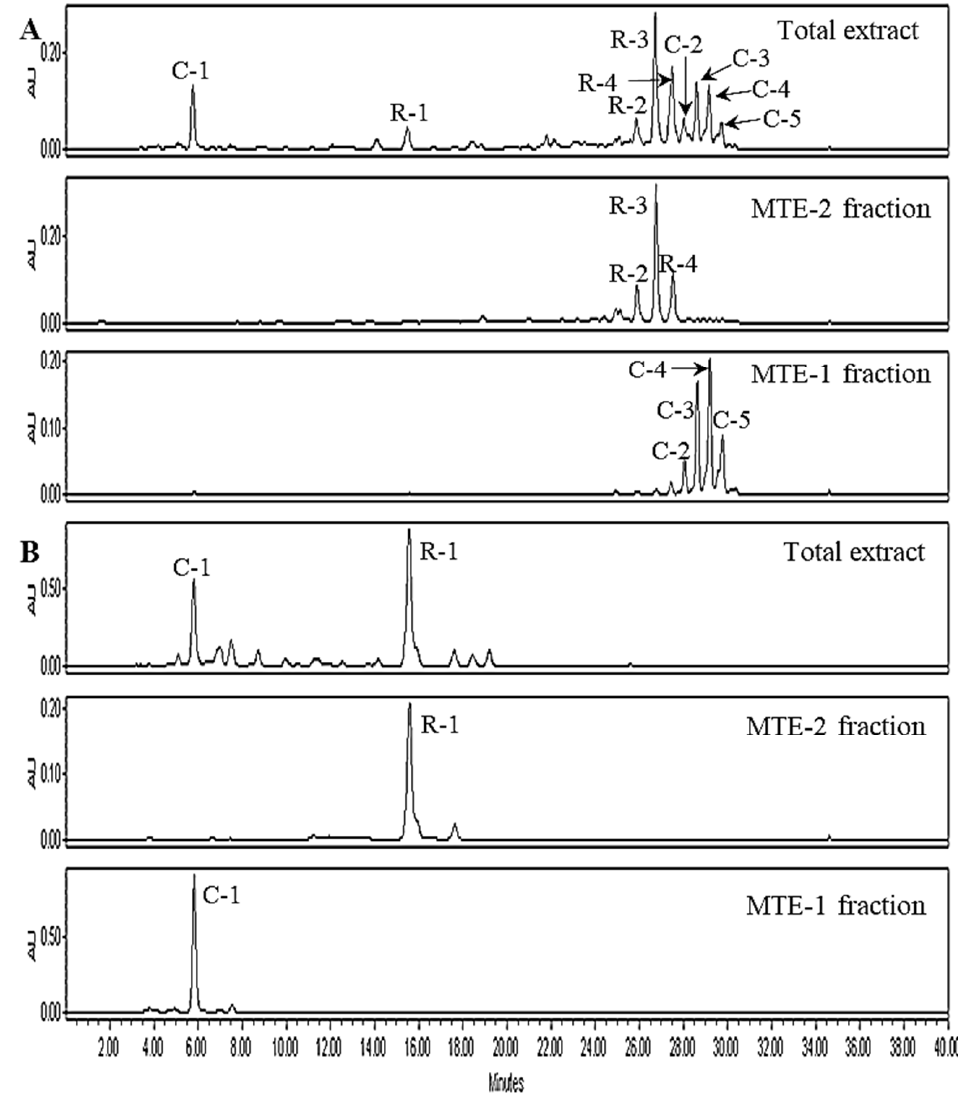
Figure 2. HPLC profiles of total extract, MTE-1 and MTE-2 fractions isolated from ripe MT fruits. ( A ), unsaponified; ( B ), saponified. HPLC conditions: column, Sunfire C 18 (250 × 4.6 mm, 5 µm, Agilent Technologies); mobile phase, acetone ( A ) and deionized water ( B ); gradient condition, A:B = 80:20 (0–15 min), 95:5 (15–20 min), 100:0 (20–30 min) and 80:20 (30–40 min); flow rate, 1.0 mL/min; detection, PDA (450 nm).